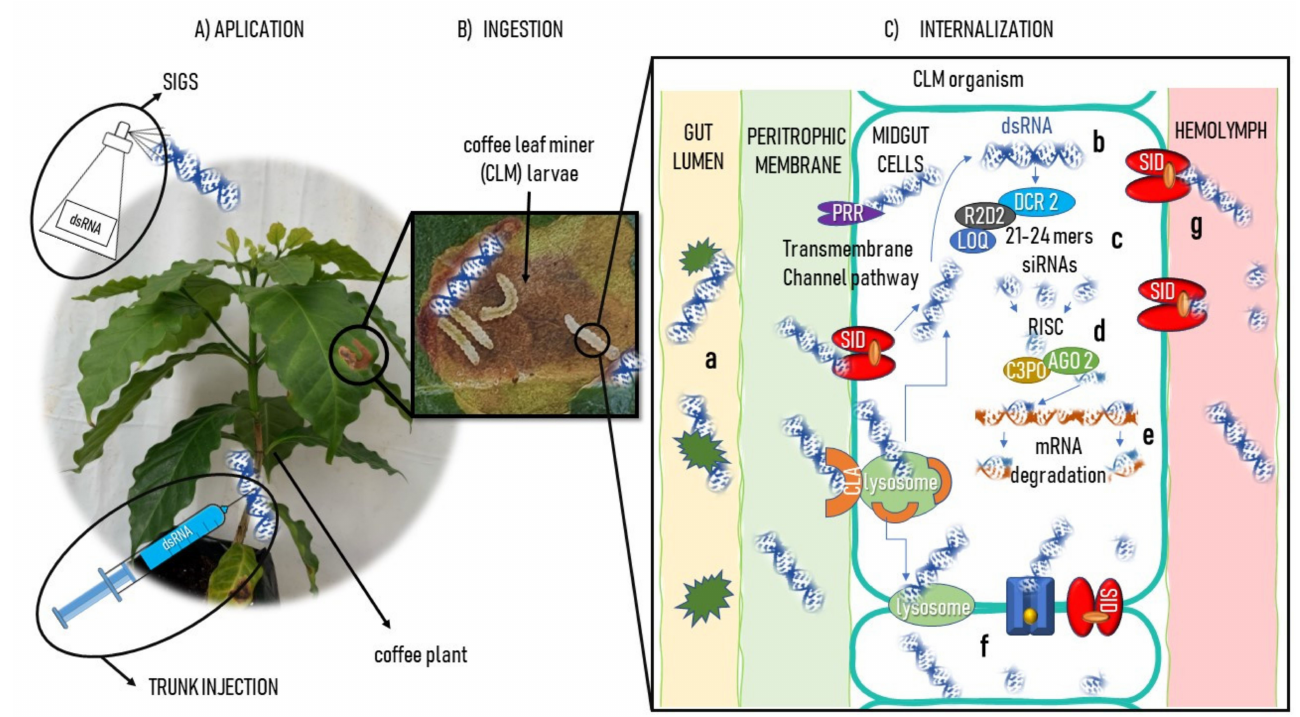
Figure 2. Schematic strategy of RNAi to control L. coffeella by long dsRNA-induced silencing of coffee plants. ( A ) dsRNA delivery by SIGS or trunk injection; ( B ) dsRNA oral ingestion by larva feeding the leaf parenchyma; ( C ) dsRNA internalization in the larva: a transfer from insect gut lumen to midgut cells by the clathrin-mediated endocytic pathway (CLA), pattern recognition receptors (PRRs), and/or RNA-binding proteins (RBPs); b long dsRNA interaction with an R2D2-DCR2 complex associated with LOQ; c LOQ recognition of exogenously delivered dsRNA to slicing by Dicer ( DCR2 ) with R2D2 to produce siRNAs; d guide-strand selection by AGO2 complexed with C3PO; e siRNA-guided silencing by attachment to the target mRNA passenger strand; systemic amplification of the RNAi silencing by dsRNA and siRNA; f dispersion through other gut cells by the cytoplasm and g diffusion to the